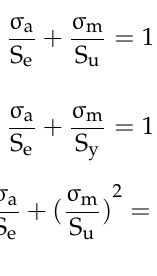
Figure 24. Results of the fatigue analysis of stem.